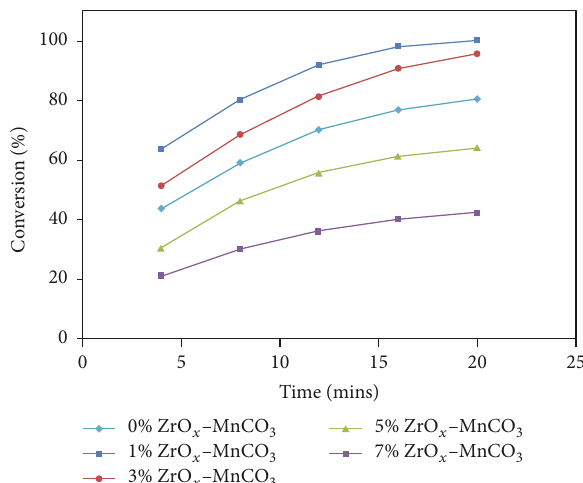
Figure 7: The effect of different weight % ZrO 1-phenylethanol.